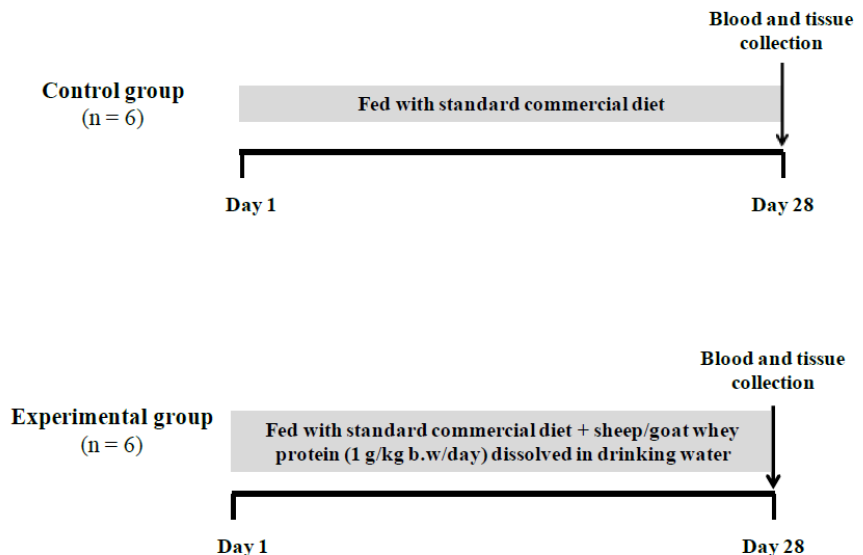
Figure 1. The study design. The control group was administered with the standard commercial diet; the experimental group was administered with the standard commercial diet plus the sheep/goat whey protein (1 g/kg of body weight/day) dissolved in drinking water. Animals maintained on their respective diet for 28 days. The downward arrows indicate the time of blood and tissue sampling.